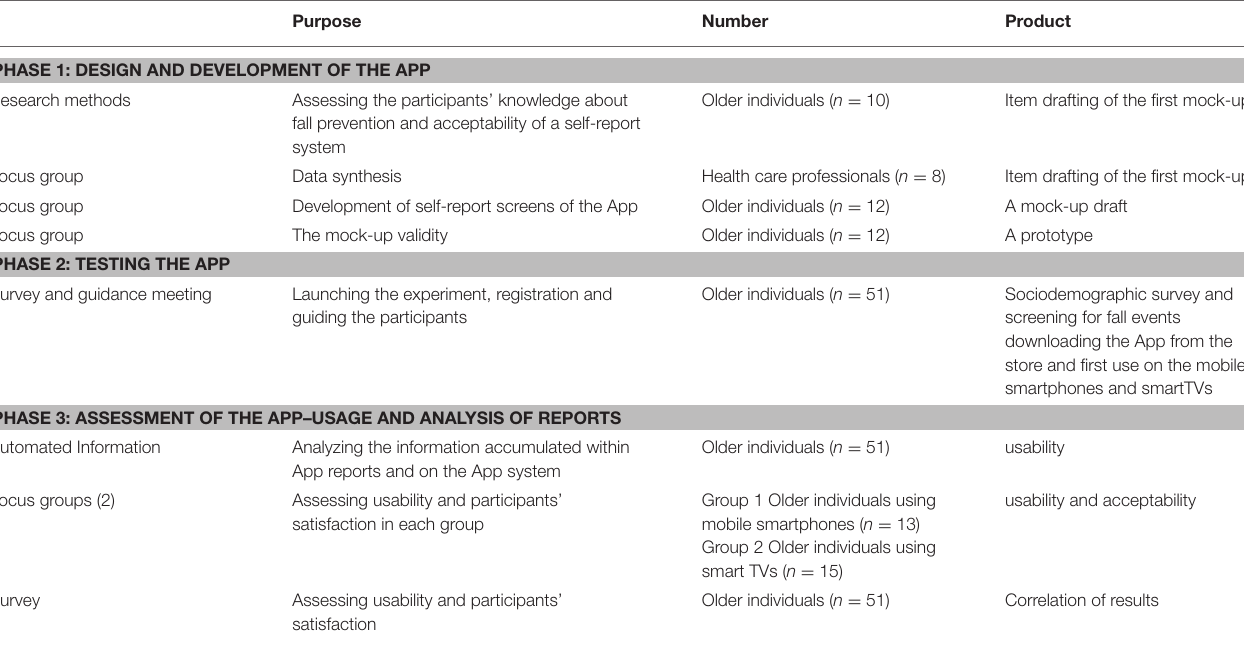
TABLE 1 | Components of the research and development process of the